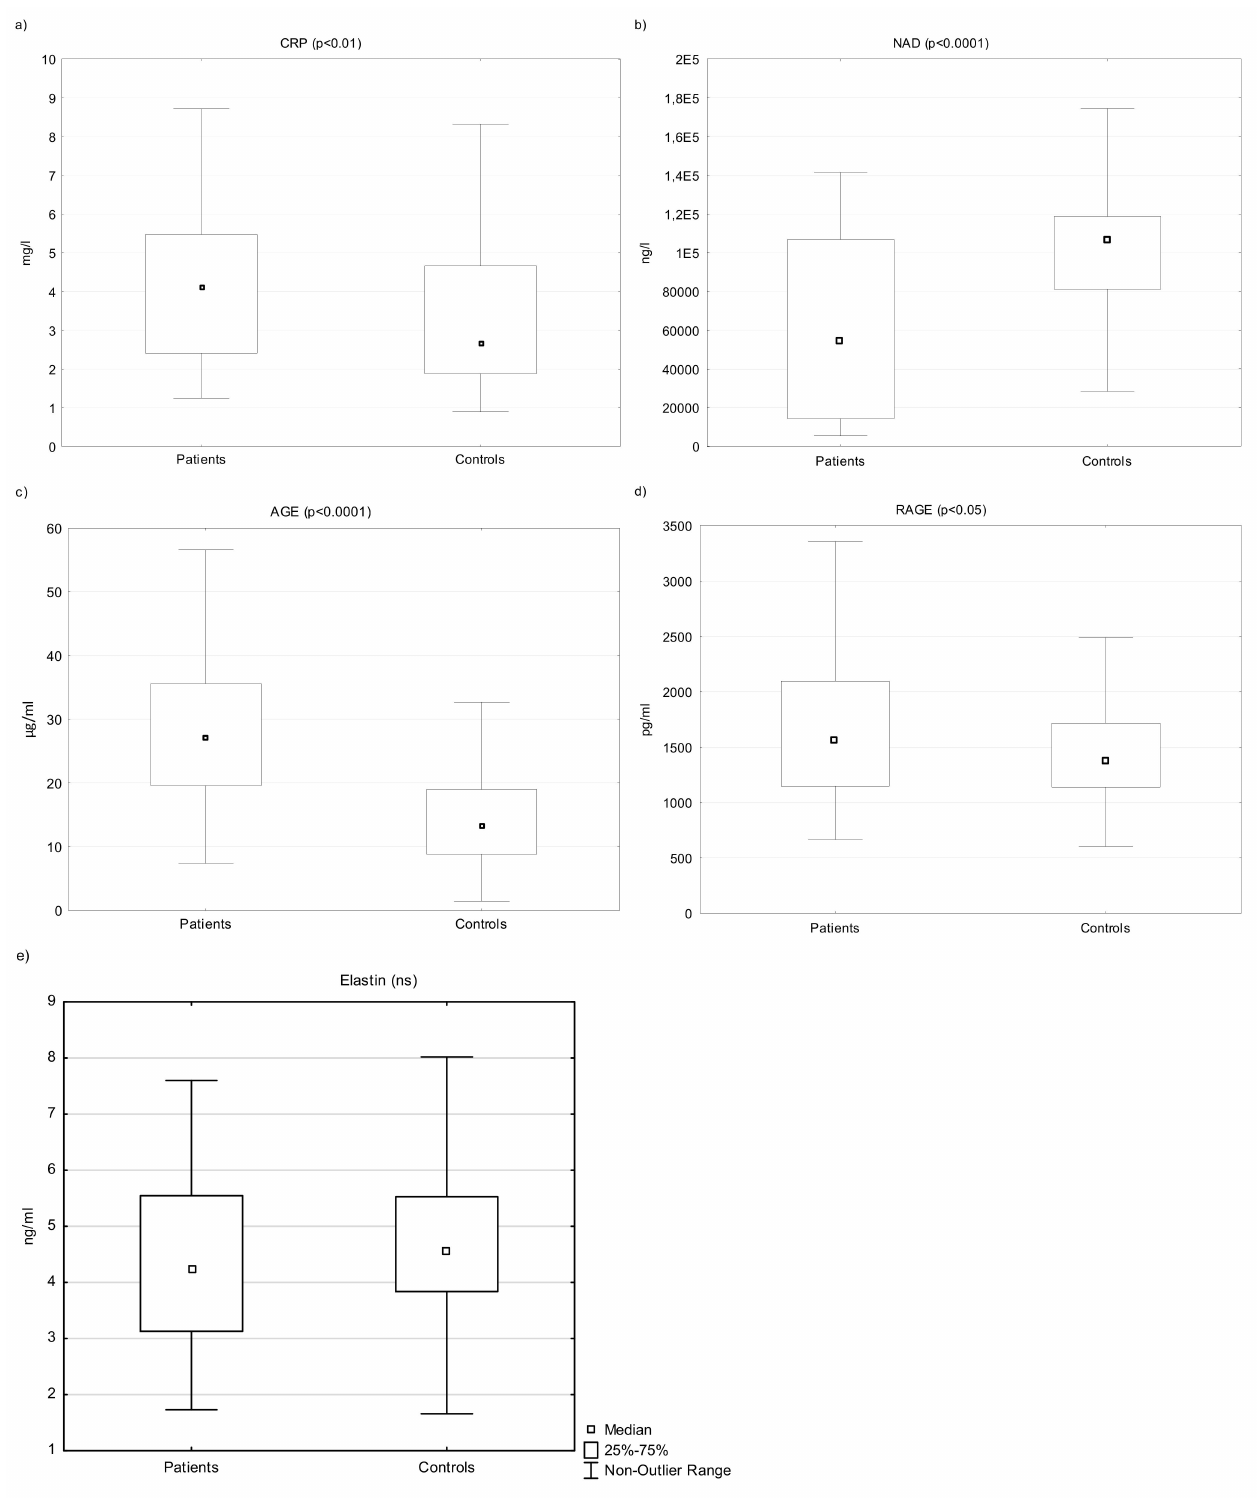
Figure 1. The levels of serum CRP ( a ), NAD ( b ), AGE ( c ), RAGE ( d ), and elastin ( e ) in patients and controls. Legend: An outlier is any data point value >75th percentile + 1.5 × (75th percentile—25th percentile) or any data point < 25th percentile—1.5 × (75th percentile—25th percentile). ns = not